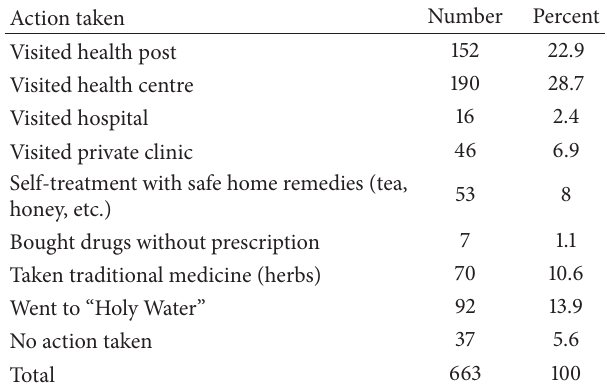
Table 2: First action taken by pulmonary tuberculosis suspects in Lay Armachiho district, Northwest Ethiopia, 2014 ( 𝑛 = 663